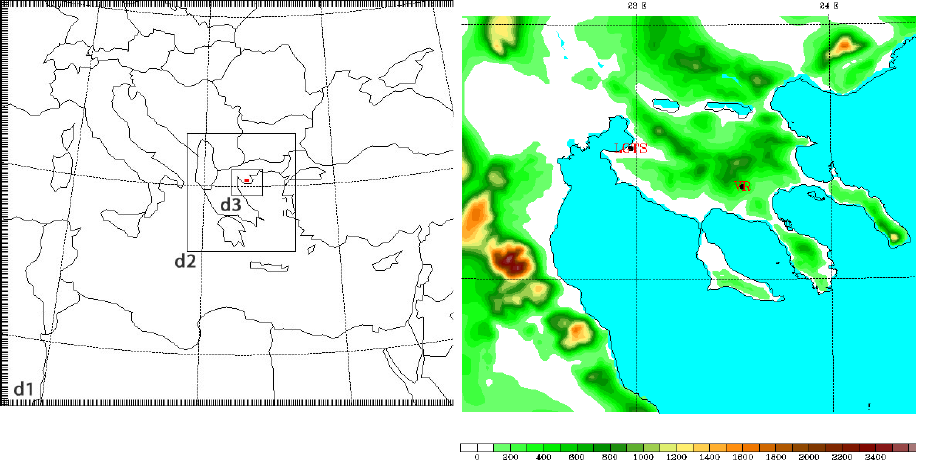
Figure 4. The three domains (D1-D2-D3) of WRF runs (the red spot indicates the tornado event area) (a) and the topography (m) of domain D3 (b) ; LGTS is the airport of Thessaloniki and VR stands for Vrastama.